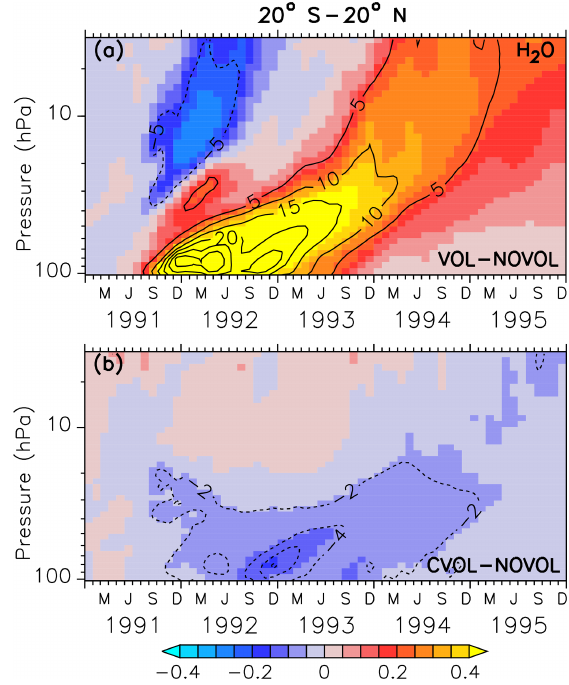
Figure 14. Zonally averaged differences in stratospheric water vapour (ppmv) between the simulations, where (a) shows the combined effect (VOL − NOVOL) and (b) the chemical effect (CVOL − NOVOL). The black contours show the relative change (%) of water vapour in comparison to NOVOL and CVOL. Shown are tropical averages (20 ◦ S–20 ◦ N). Contour intervals are 5% (a) and 2% (b)